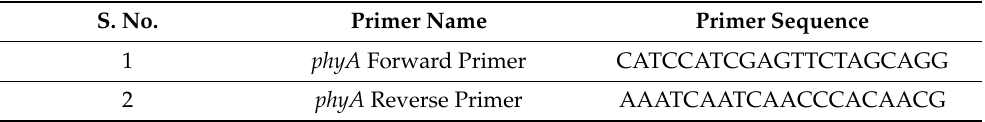
Table 3. Sequence of gene-specific primers used for colony PCR.